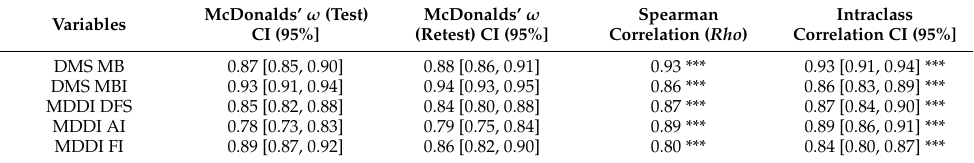
Table 5. Internal consistency and test–retest reliability of the DMS and the MDDI for Brazilian cisgender gay and bisexual adult